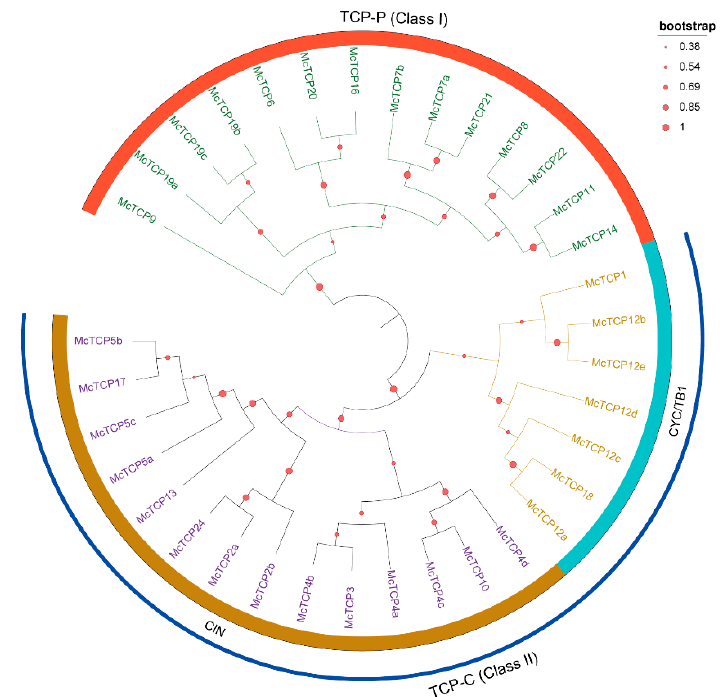
Figure 2. Phylogenetic evolution of TCP family members. Different colors of the outer ring denote the three main TCP genes. The blue arc represents TCP-C -type genes. The red dots on the tree branches represent bootstrap value. The size of the dots is in proportion to the bootstrap value.